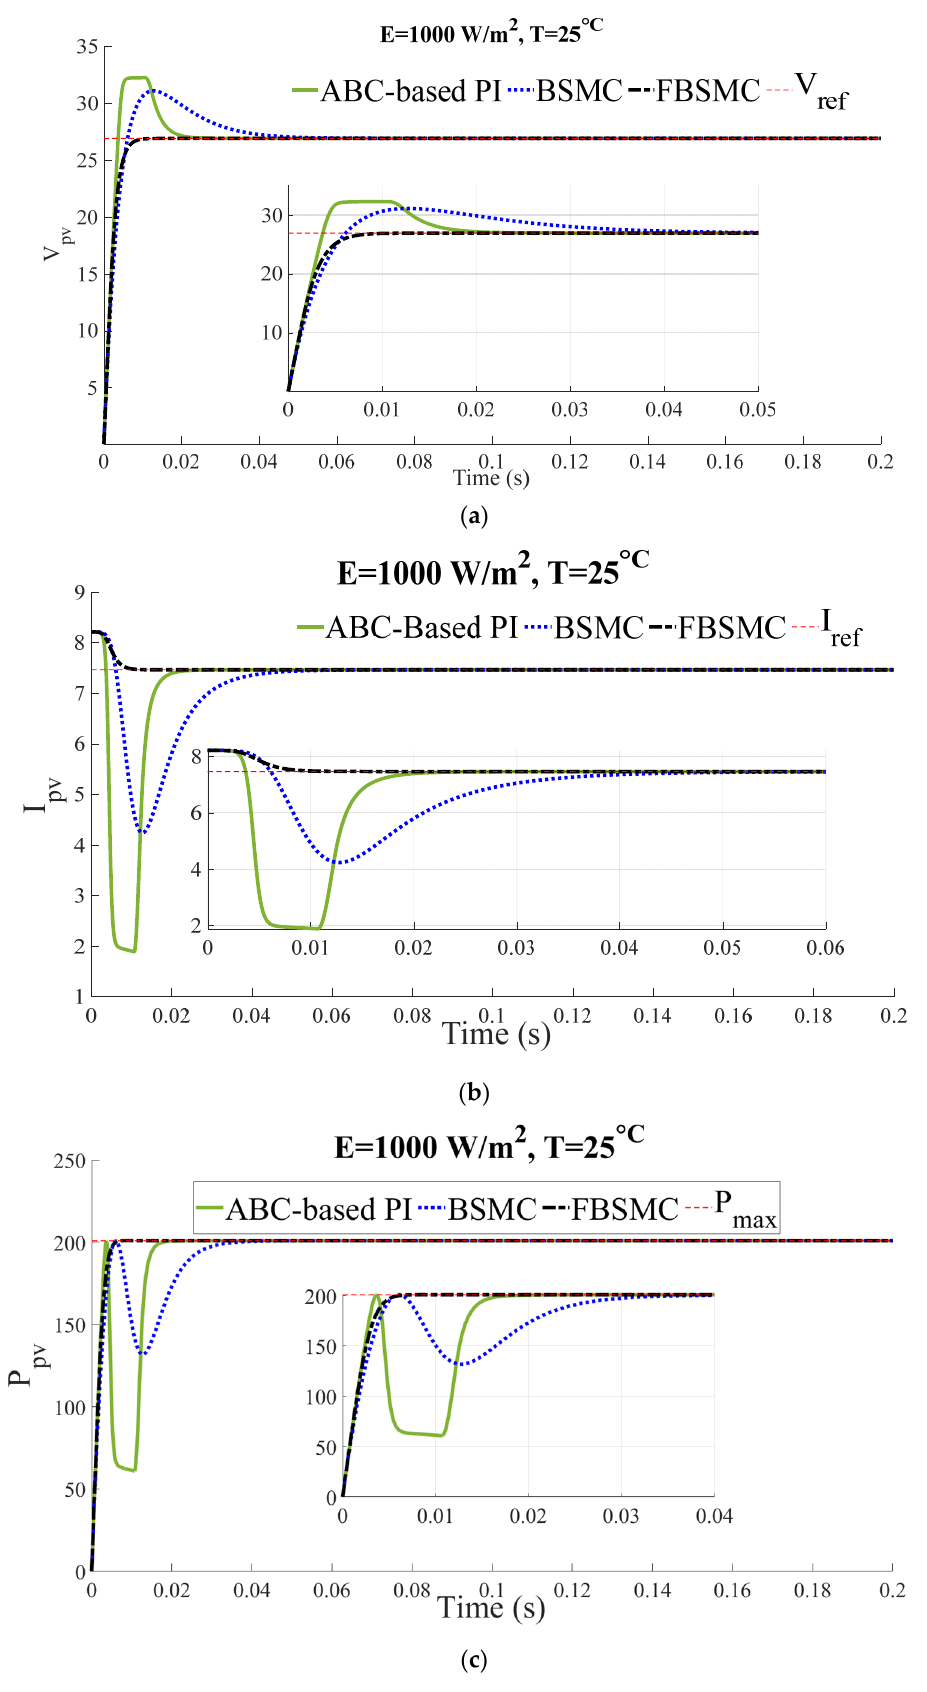
Figure 4. ( a ) Voltage ( b ) current, ( c ) power of the controlled PV (Scenario 1).